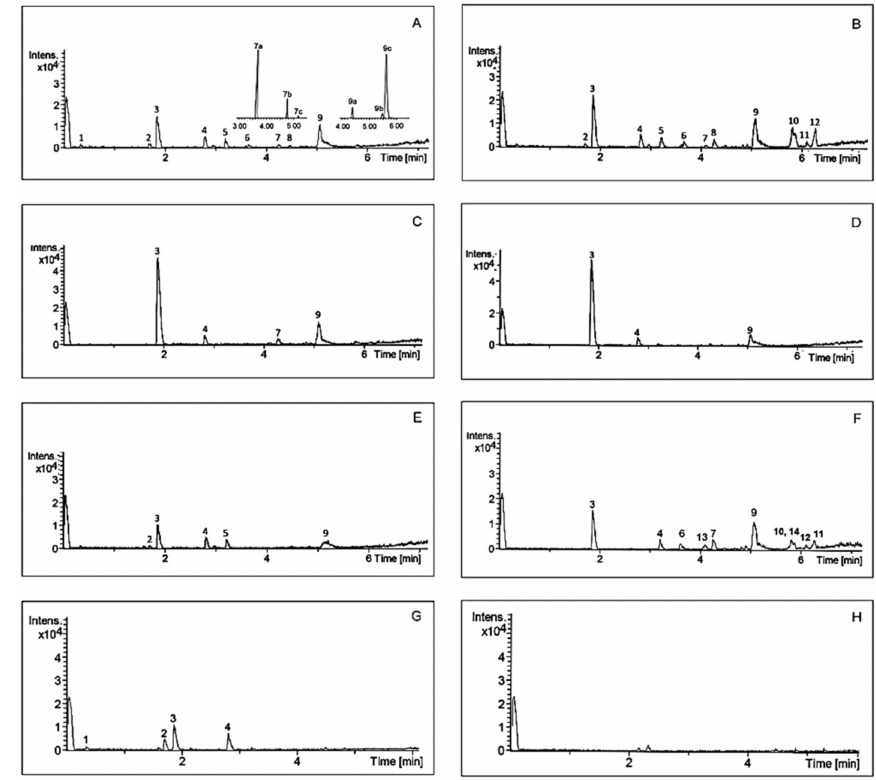
Figure 3. Chromatograms of A. theiformis EHs extract ( A ) and its fractions ( B – H ) obtained by UPLC-QTOF-MS. Sto1g ( B ), Sto1p ( C ), Sto2p ( D ), Tf ( E ), n -butanol ( F ), ethyl acetate ( G ), and water ( H ). For peak numbers see Table 3. Table 3. Chemical profile of A. theiformis EHs extract and its fractions analysed by UPLC-QTOF-MS. Peak